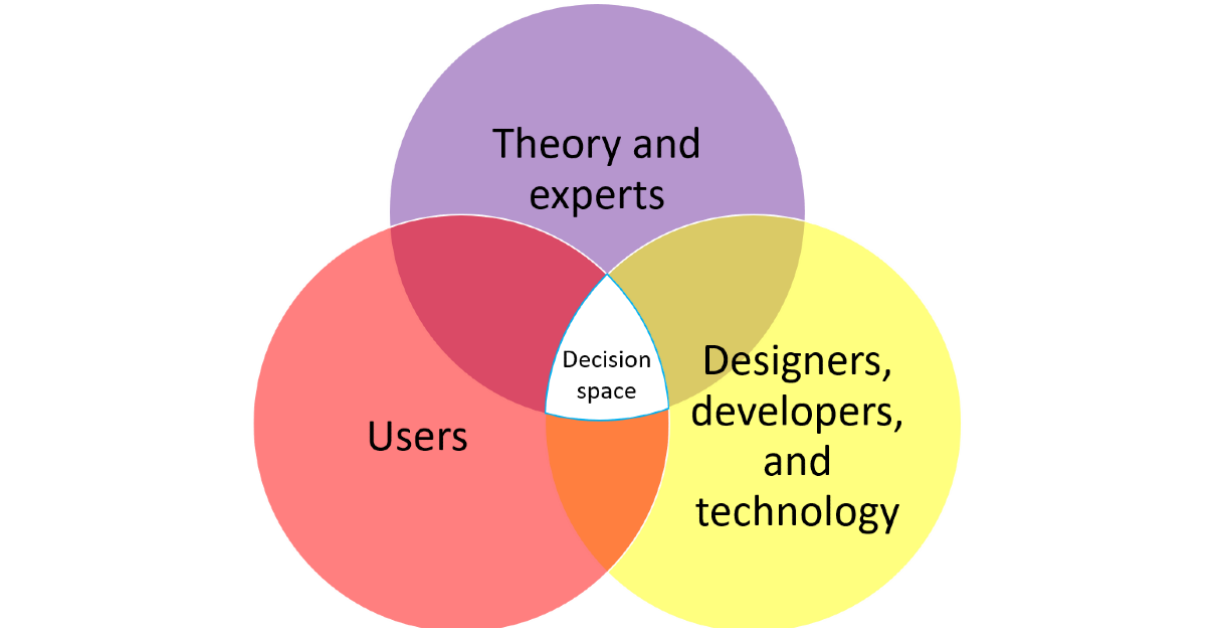
Figure 16. Venn diagram of decision